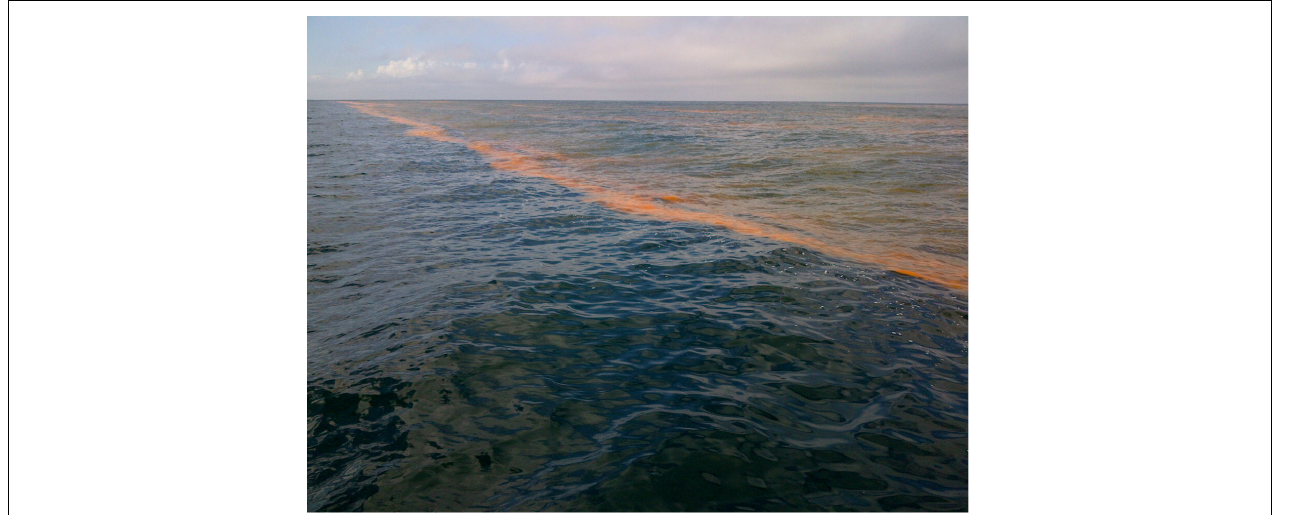
FIGURE 2 | Image of coastal front with indicative surface slick observed by the naked eye (image Paula